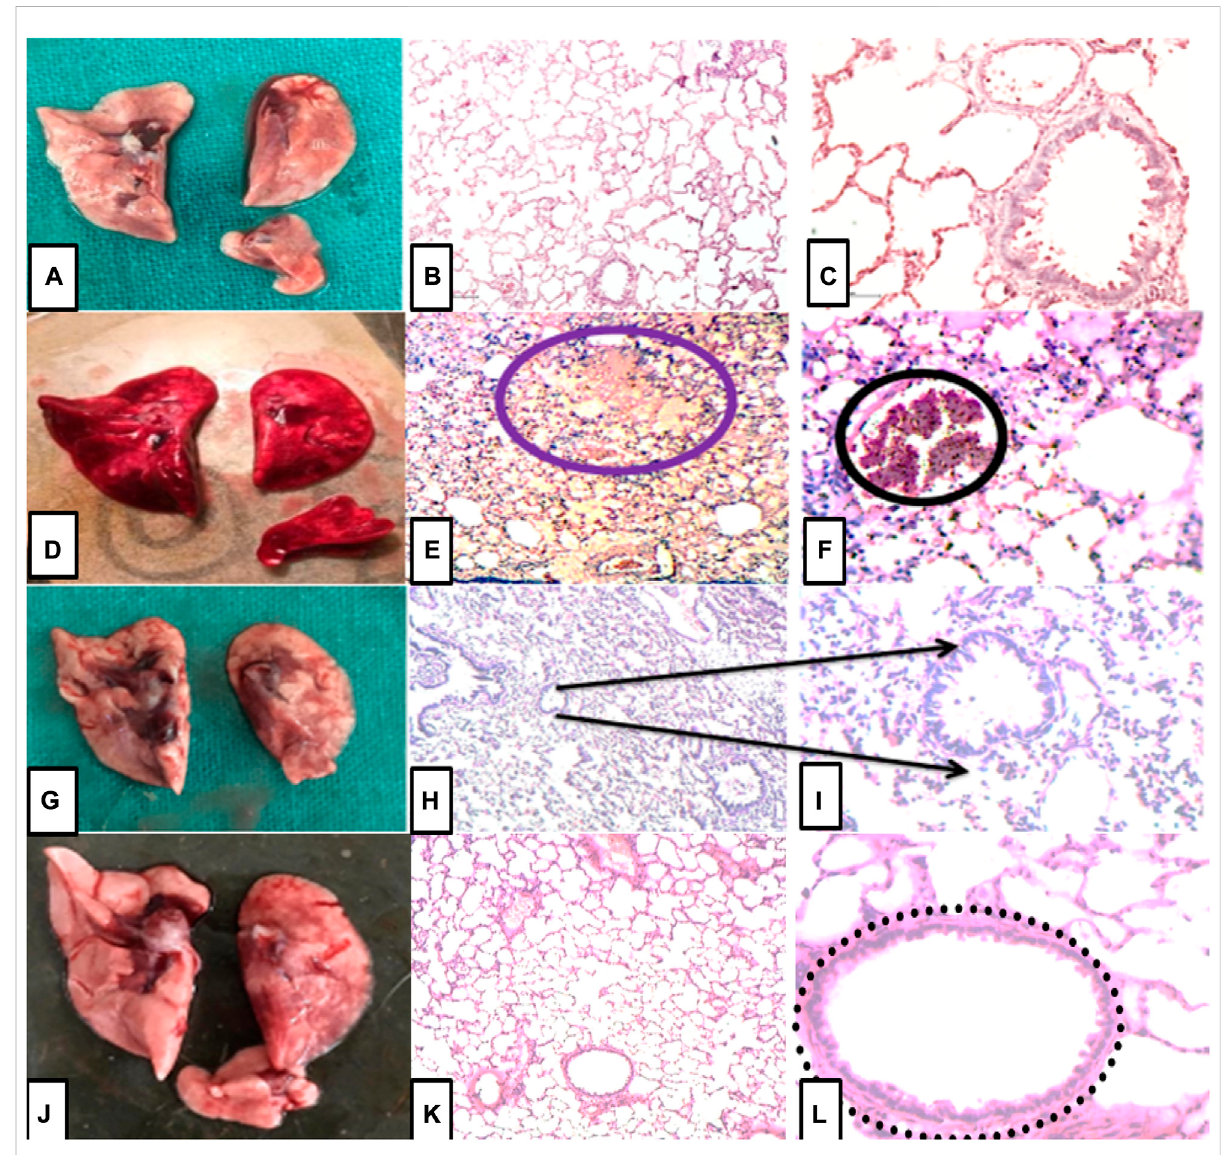
FIGURE 11 Pathological changes in the lungs of rats in each group. Surface morphology of lung in group I (A) , group II (D) , group III (G) , and group IV (H) .×10magni fi cation oflung ingroupI (B) , group II (E) , groupIII (H) and group IV (K) .×40 magni fi cationofthelung ingroup I (C) ,group II (F) , group III (I) , and group IV (L) . Here, the solid black circle denotes hemorrhagic clumping in the alveolar region, and the black arrows in (I) denote the damaged lining of the alveolus, whereas a dotted circle in (J) denotes the intact alveolus useful for gaseous exchange. The lung injury score (below) revealed signi fi cant relevance of group IV (B.T. 1.5 g/kg BW) to group I. Comparisons between groups were performed using one-way ANOVA (Turkey ’ smultiplecomparisontests)to compare themeanvalues ofeachgroupwith eachother.( *p < 0.05,***p < 0.01,and****p < 0.001